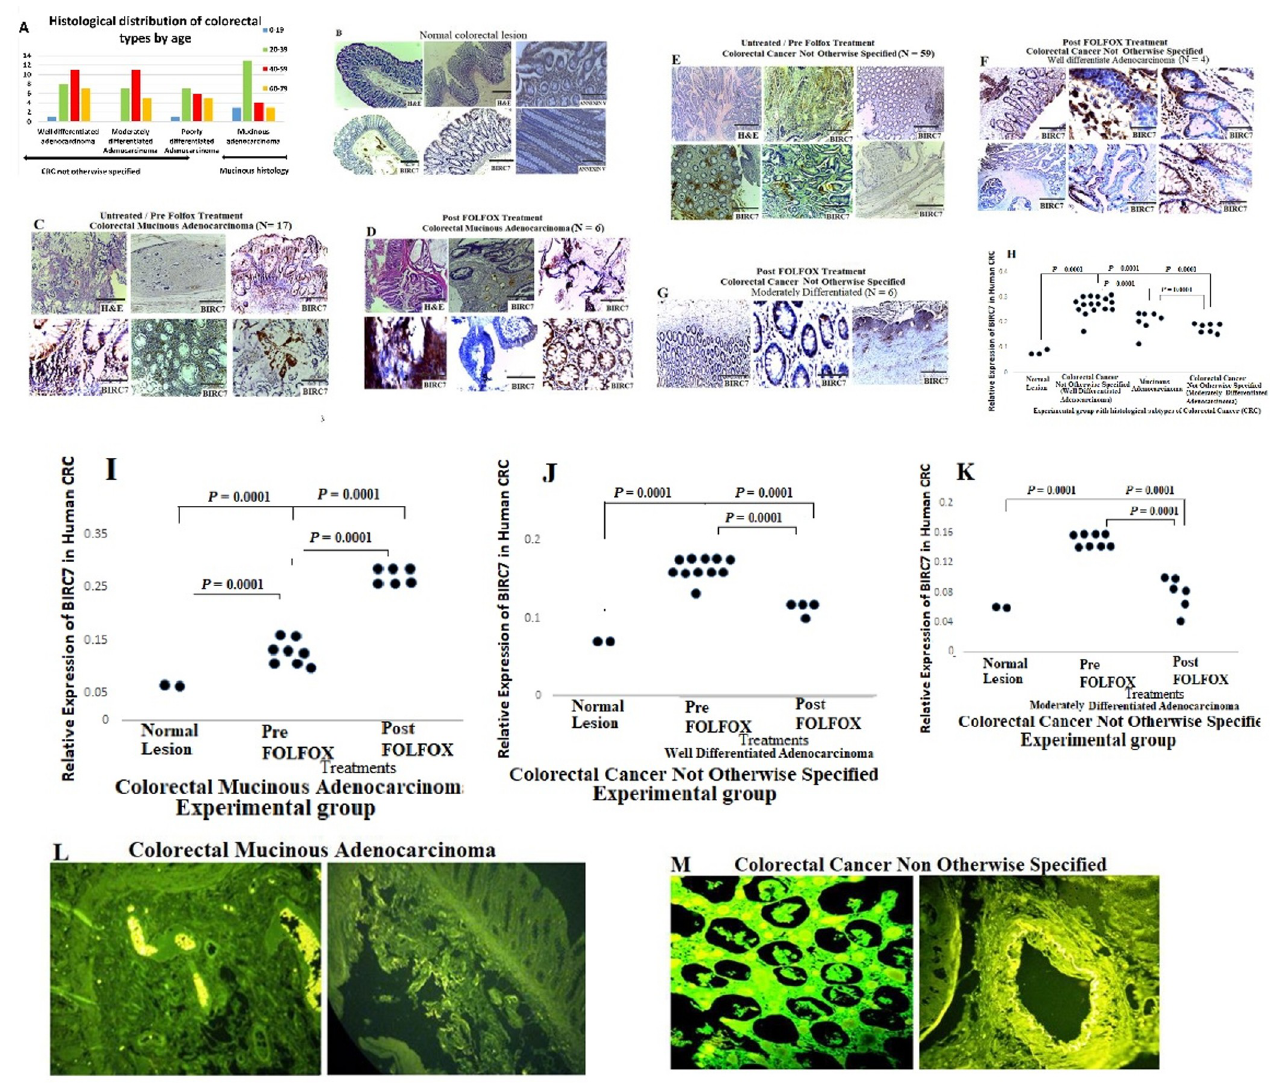
Fig 3. The expression pattern and functional significance of BIRC7/Livin pre and post- FOLFOX treatment in human colorectal cancer (scale bar = 50 μ m for H&E and scale bar = 100 μ m for IHC). A) A bar chart showing the age distribution of different CRC subtypes used in the study in Zaria Nigeria. B) Normal colorectal sections showing negative expression of BIRC7/Livin Scale bar, 20 um. C) Colorectal mucinous adenocarcinoma sections showing positive expression of BIRC7/Livin pre-FOLOFOX treatment, Scale bar, 20 um. D) Colorectal mucinous adenocarcinoma lesions showing increase expression of BIRC7/Livin post-FOLFOX treatment. E-G) Colorectal cancer not otherwise specified (well and moderate differentiated) sections pre and post- FOLFOX chemotherapy showing increase expressions of BIRC7/Livin Scale bar, 20 um. H-K) BIRC7/Livin expression pattern typified in dot plot and showing pattern of the proteins expression using quantitative analysis technique. L-M) Representative IF images showing positive expression of BIRC7 in mucinous CRC histology and CRC not otherwise specified.